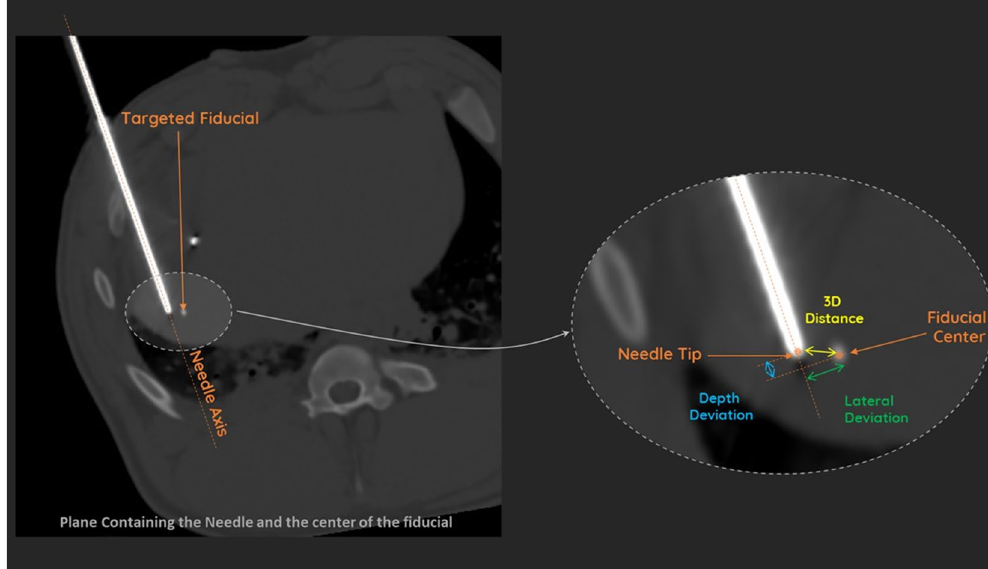
Figure 5. Measurement of 3D (Euclidian), lateral and depth deviations (Myrian software, Intrasens, Montpellier,